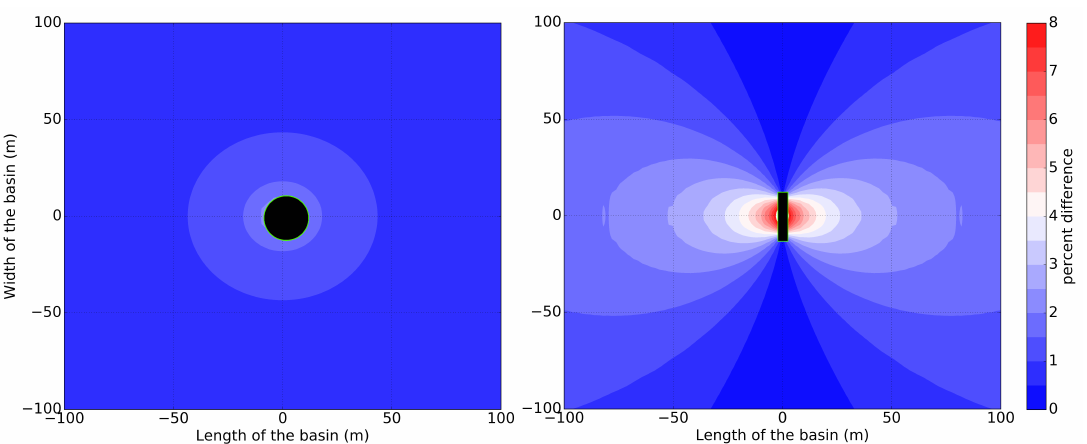
Figure 9. Percent difference (Equation (29)) in the total wave field between the hydraulic and linear PTO system for a heaving cylindrical WEC ( left ) and OSWEC ( right ). Incident wave of H = 1.0 m, T = 8.0 s propagating from the